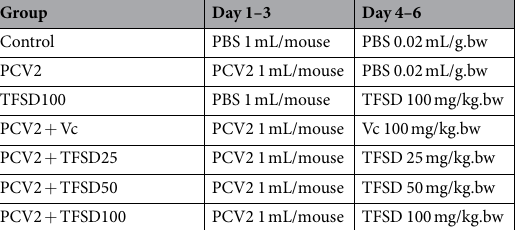
Table 1. Grouping and treatment of mice. * Mice were inoculated with PCV2 via intragastric administration (0.5 mL/mouse) and intraperitoneal injection (0.5 mL/mouse) daily for three days. Mice were treated with PBS, Vc or TFSD via intragastric administration on Day 4, 5 and